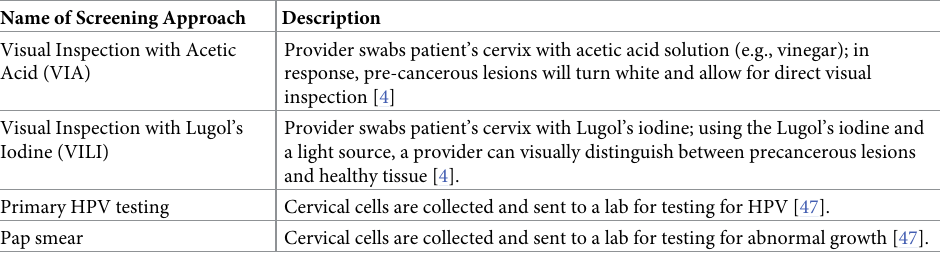
Table 2. Descriptions of screening